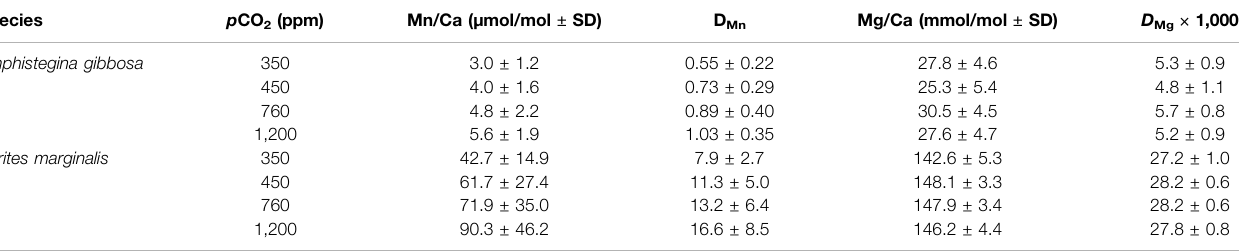
TABLE 3 | Mn/Ca and Mg/Ca [ ± standard deviation (SD)] and element partitioning with propagating SD of hyaline species Amphistegina gibbosa and porcelaneous species Sorites marginalis cultured at different p CO 2 . Species p CO 2 (ppm) Mn/Ca (µmol/mol ± SD) D Mn Mg/Ca (mmol/mol ± SD) D Mg × 1,000 Amphistegina gibbosa